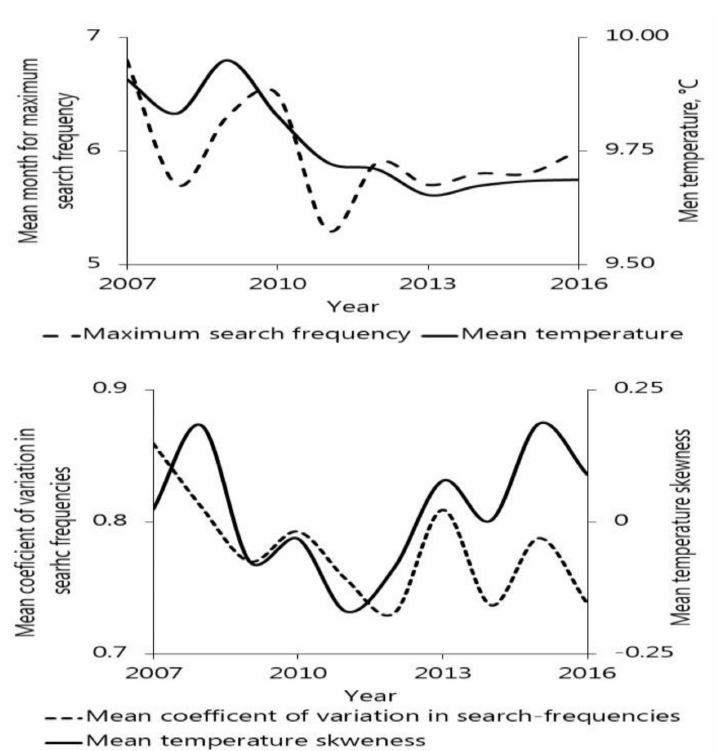
Figure 5. An illustration of how shifting within-years characteristics can be used to inform on the changes that occur over longer timespans. The inter-annual trends in mean month of maximum search activity vs. mean temperature ( top ) represents a conventional approach. The plot showing the coefficient of variation vs. temperature skewness for all nine regions in the period 2007 to 2016, includes an unconventional interpretation/representation of temperatures. Mean values are based on the nine